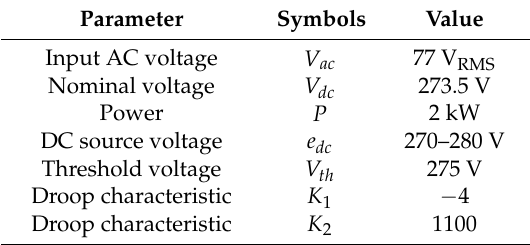
Table 3. Parameters for the Prototype Bidirectional Converter. Figure 16. Step load change for the control system verification.